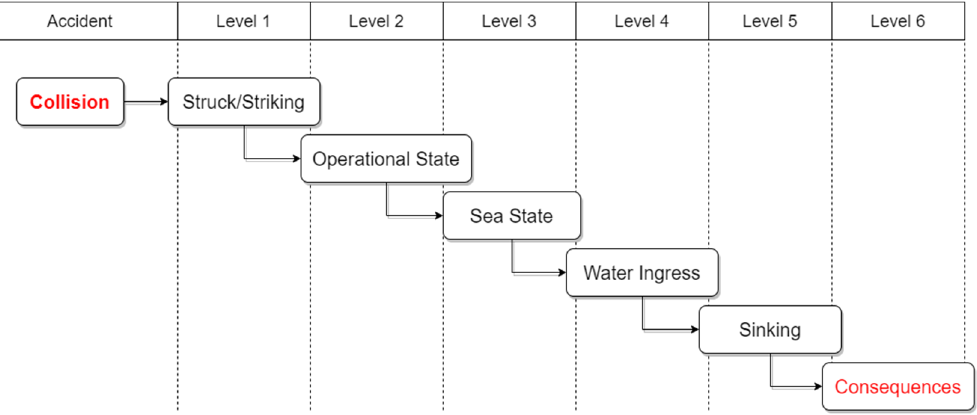
A high-level event sequence for collision accidents that was adapted from the GOALDS project